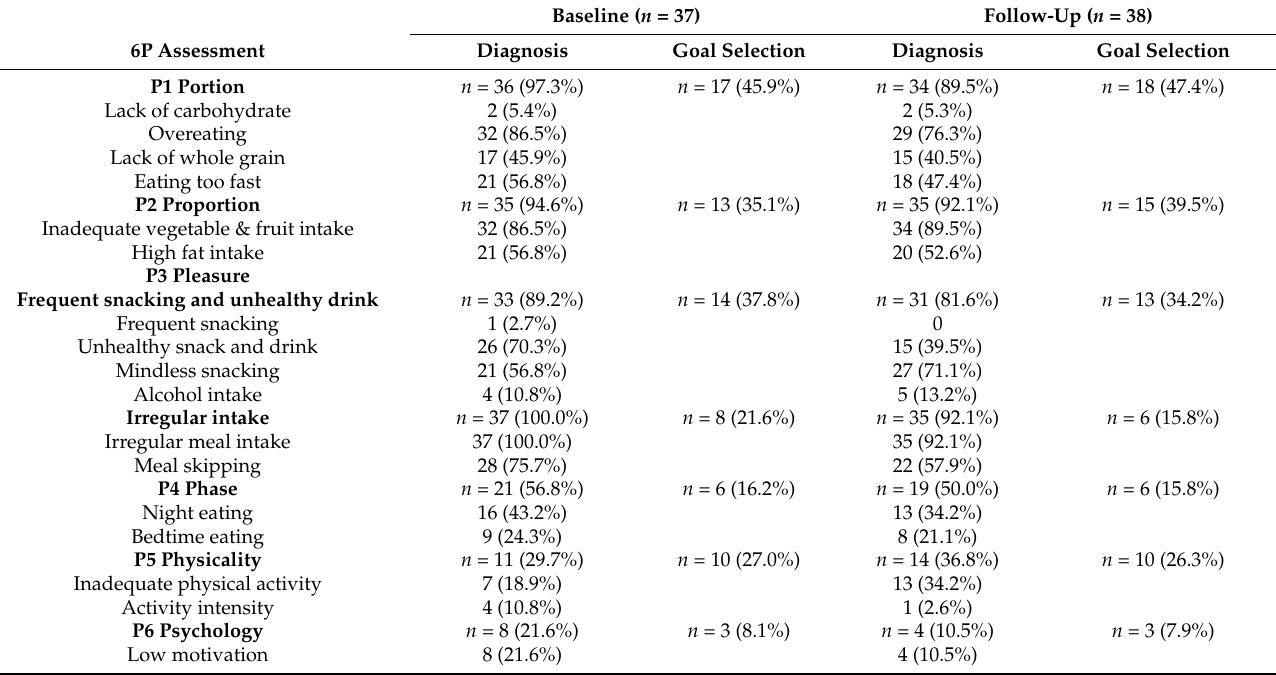
Table 4. 6P diagnosis problem and goal selection at baseline and one-month